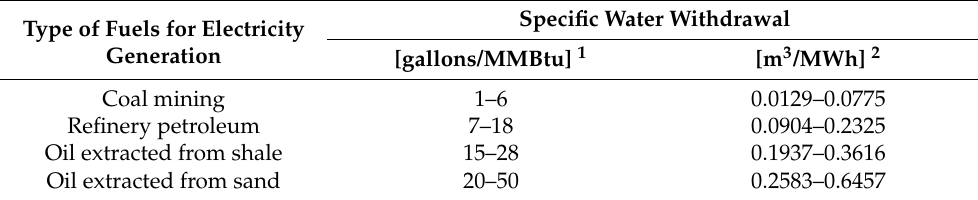
Table 6. Specific water withdrawal for extraction and preparation of input fuels for electricity generation, adapted after